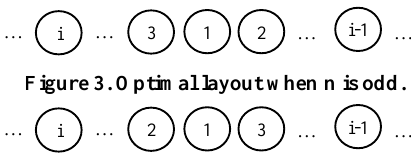
Figure 3. Optimal layout when n is odd.